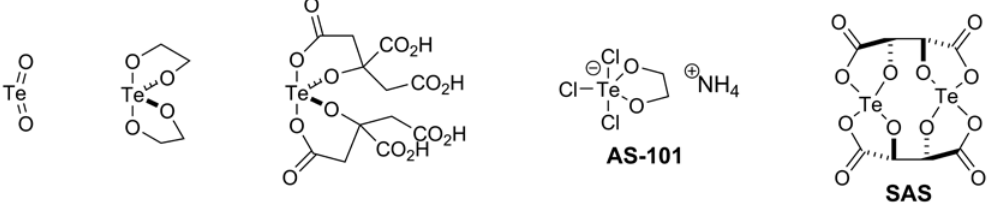
Fig. 12 – Inorganic telluranes as specific cysteine protease inhibitors.